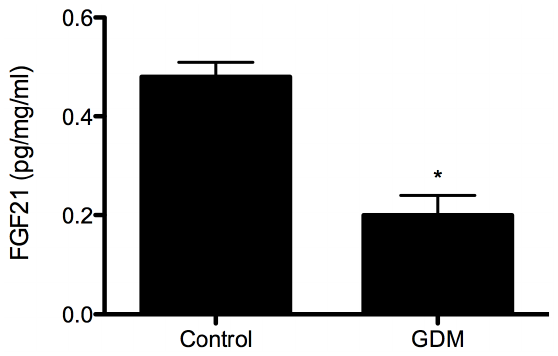
Figure 2. FGF21 levels in conditioned media of placental explants at 48 hours were assessed by ELISA. Four independent experiments were performed. Group comparison by Mann-Whitney U test. * P ,